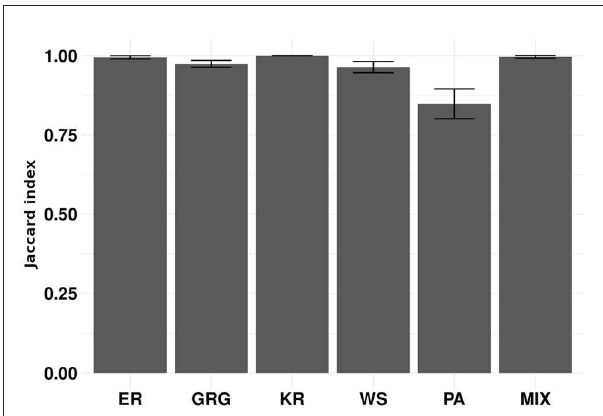
FIGURE5 Each bar represents a scenario of simulation 3 in 100 repetitions. We sampled the sizes of the graphs uniformly between 30 and 120. The scenarios are composed of the following random graph models: Erdös-Rényi (ER), geometric (GRG), k-regular (KR), Watts-Strogatz (WS), preferential attachment (PA), and a mixture of geometric, k-regular, and preferential attachment random graph models (MIX). The y-axis represents the average Jaccard indices obtained in 100 repetitions. Error bars represent 95% confidence intervals. The gCEM algorithm clustered graphs correctly, even when the sizes of the graphs are different.